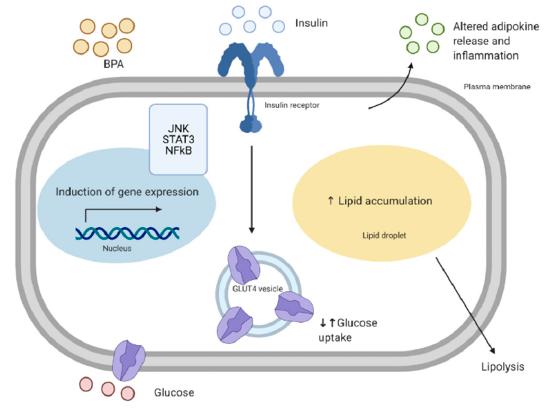
Figure 4. Mechanism of action of BPA/BPS exposure in adipocytes. In adipocytes it is not